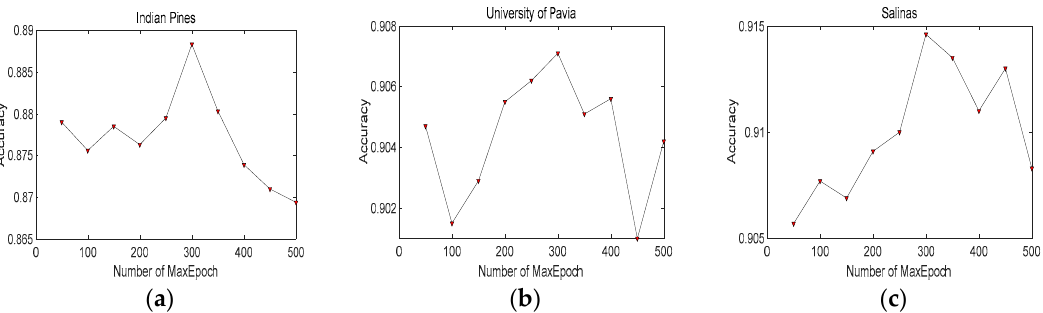
Figure 9. The relationship between accuracies and the numbers of Max epoch in different datasets: ( a ) Indian Pines; ( b ) University of Pavia; and ( c ) Salinas. Table 5. The accuracies obtained via different numbers of hidden layers in DBN.